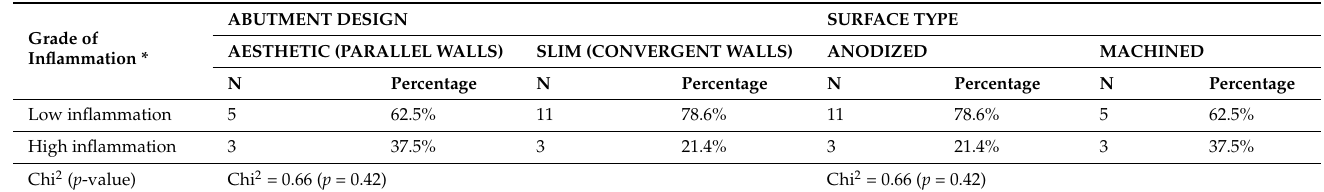
Table 4. Comparison by 2 × 2 chi-square tests of the effect of either abutment design (parallel vs. convergent) or the surface type (anodized vs. machined) on histological inflammation of the peri-implant soft tissues.